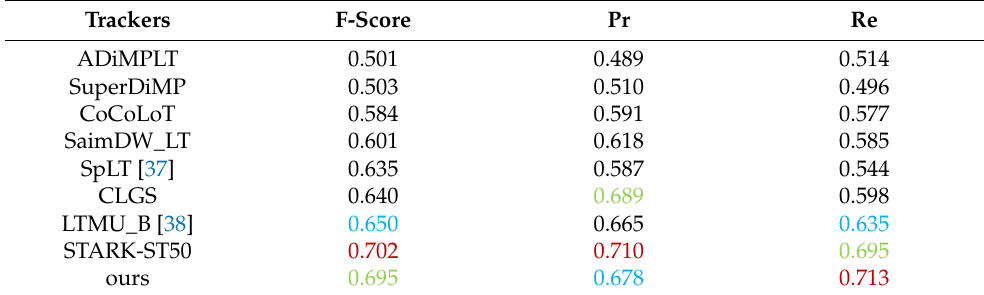
Table 6. Comparisons on VOT-LT2020 benchmark. The best three results are marked in red, green, and blue bold fonts, respectively.